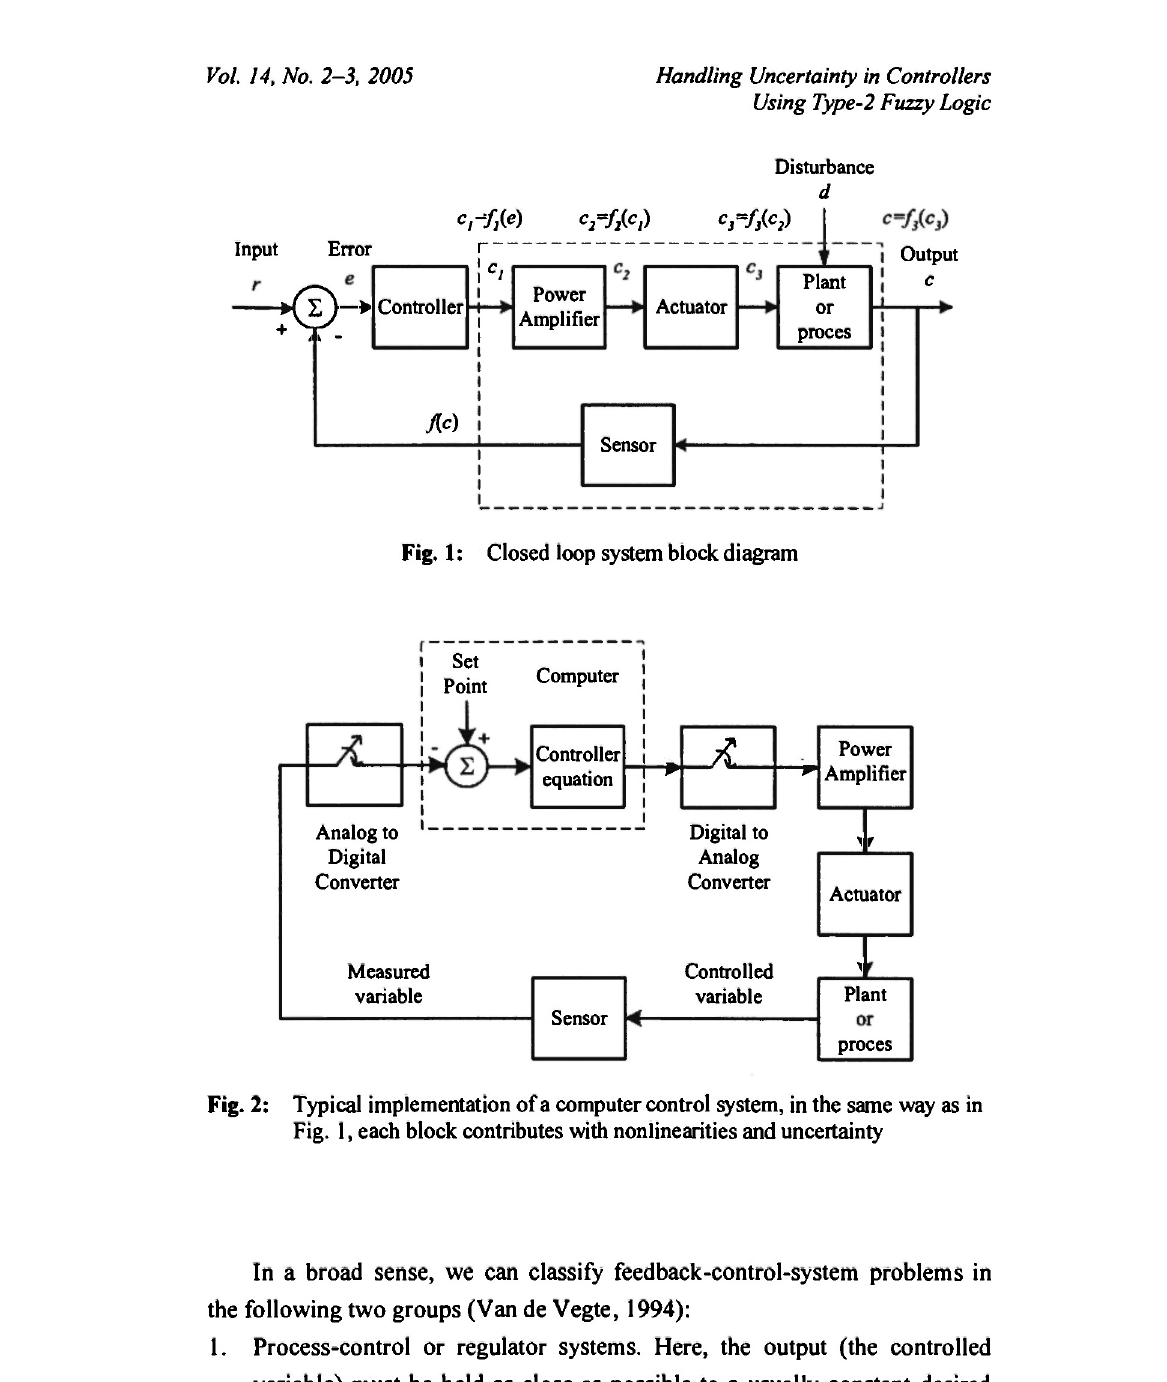
Fig. 2: Typical implementation of a computer control system, in the same way as in Fig. 1, each block contributes with nonlinearities and